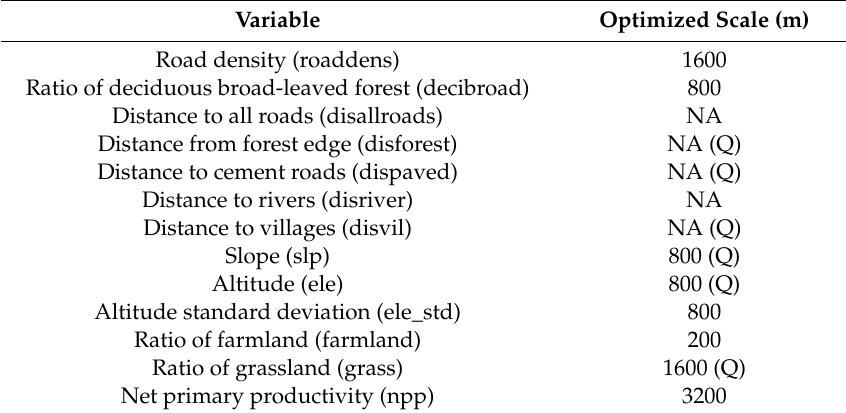
Table 2. Level II single variable optimized scale for habitat